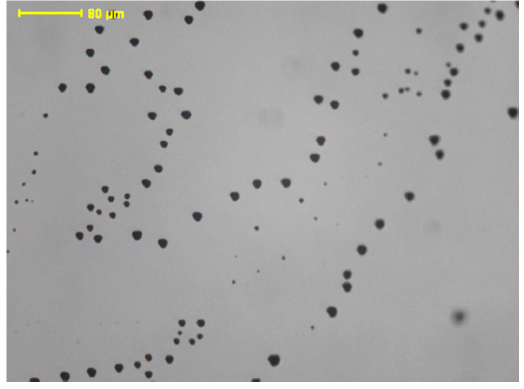
Figure 2. The typical IR image of an as-grown CMT:In crystal.